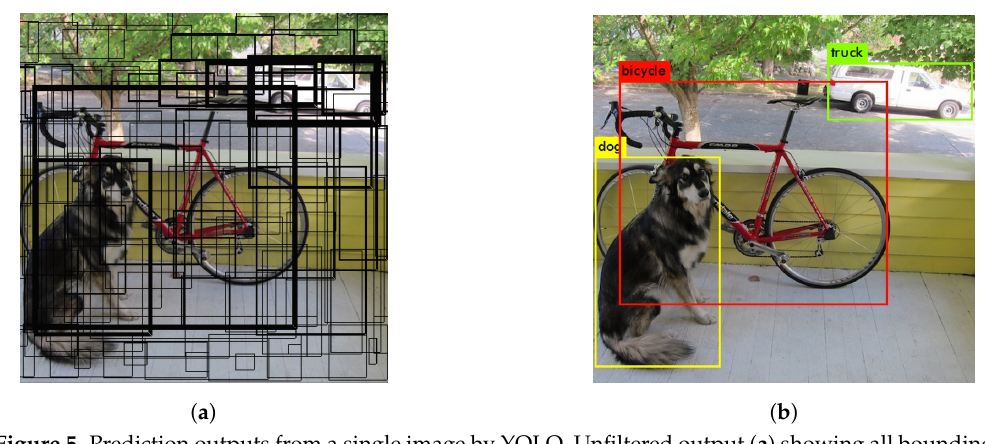
Figure 5. Prediction outputs from a single image by YOLO. Unfiltered output ( a ) showing all bounding box candidates where an object is suspected. ( b ) only shows predictions with values over a certain confidence factor. Labels representing object classes with the highest score. Source